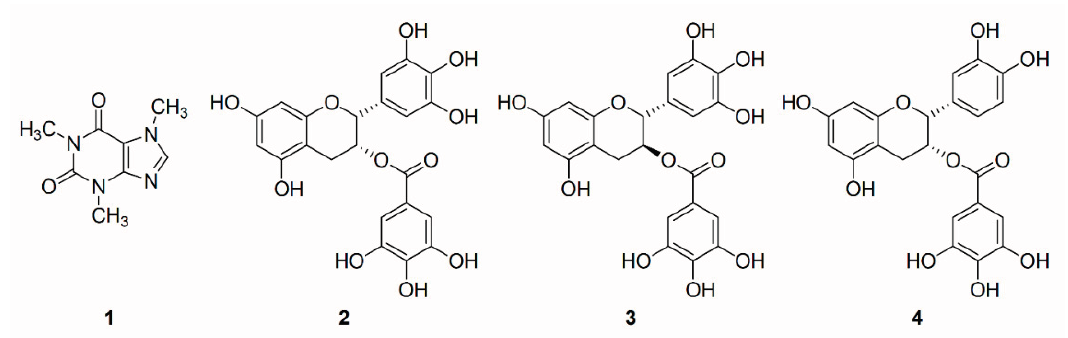
Figure 1. Structures of 1 – 4 from the acetone-soluble extract of fermented C. sinensis leaves. Compounds 1 : caffeine, 2 : ( − )-epigallocatechin 3- O -gallate, 3 : ( − )-gallocatechin 3- O -gallate, and 4 : ( − )-epicatechin 3- O